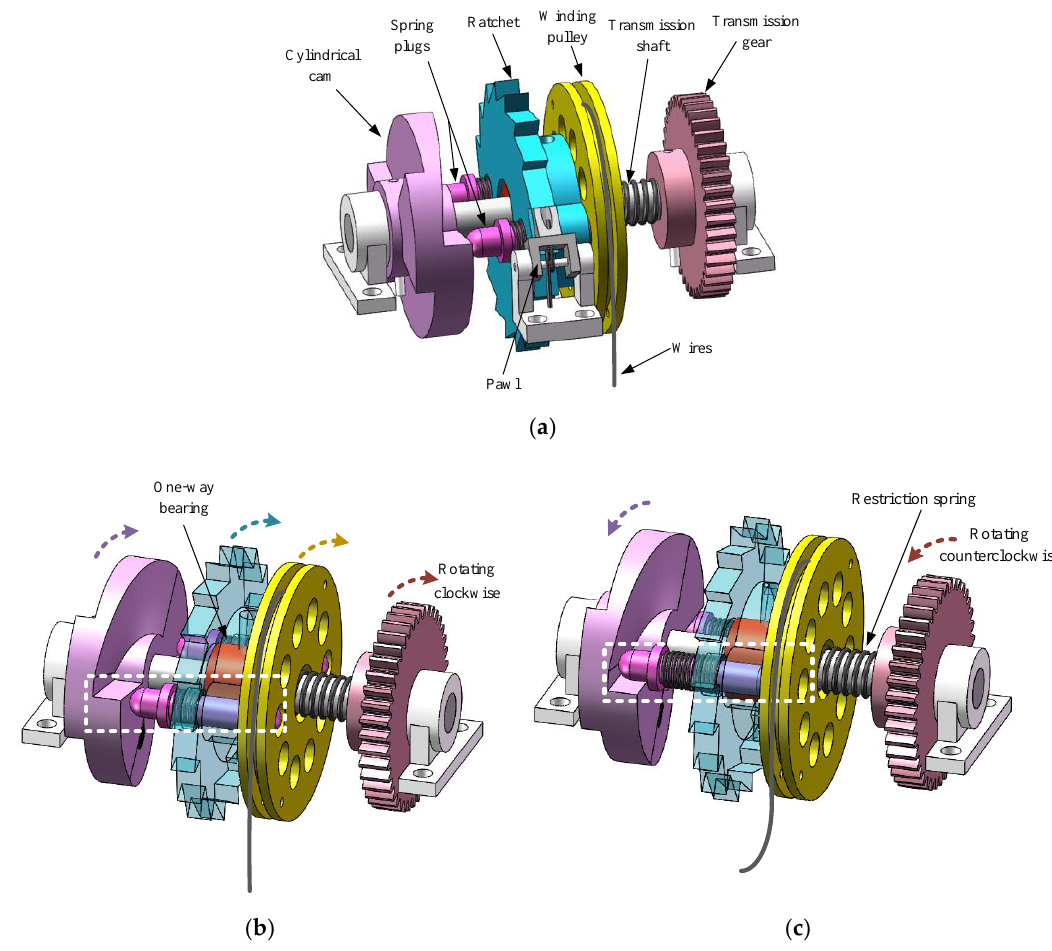
Figure 11. Composition and principle of the mechanism of loading and releasing of spring. ( a ) Overall structure; ( b ) loading; ( c ) releasing.